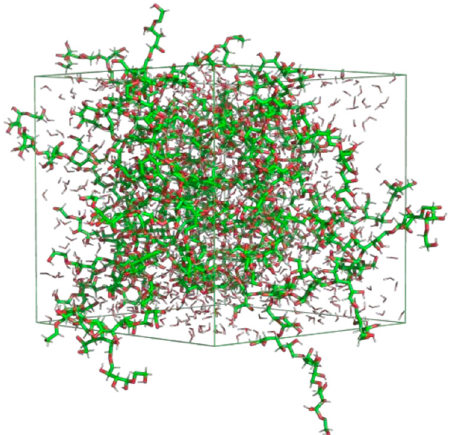
Figure 1. The cubic simulation box filled with amylose and water molecules.